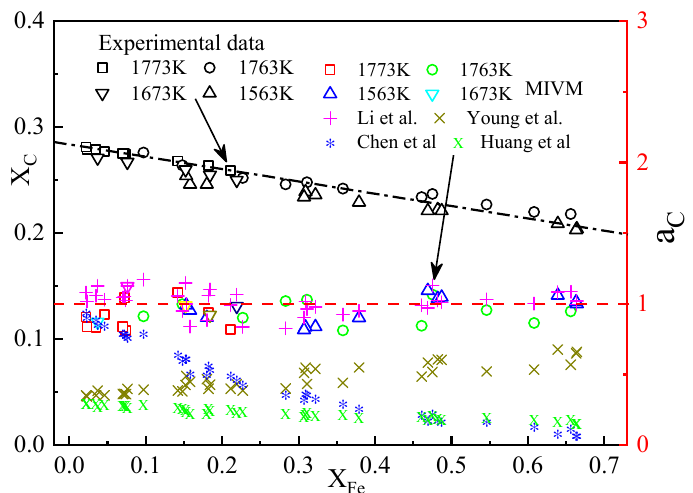
Figure 5. Calculated activity of C in liquid Fe–Mn–C alloys in equilibrium with graphite at various temperatures; experimental data were sourced from [7,8].